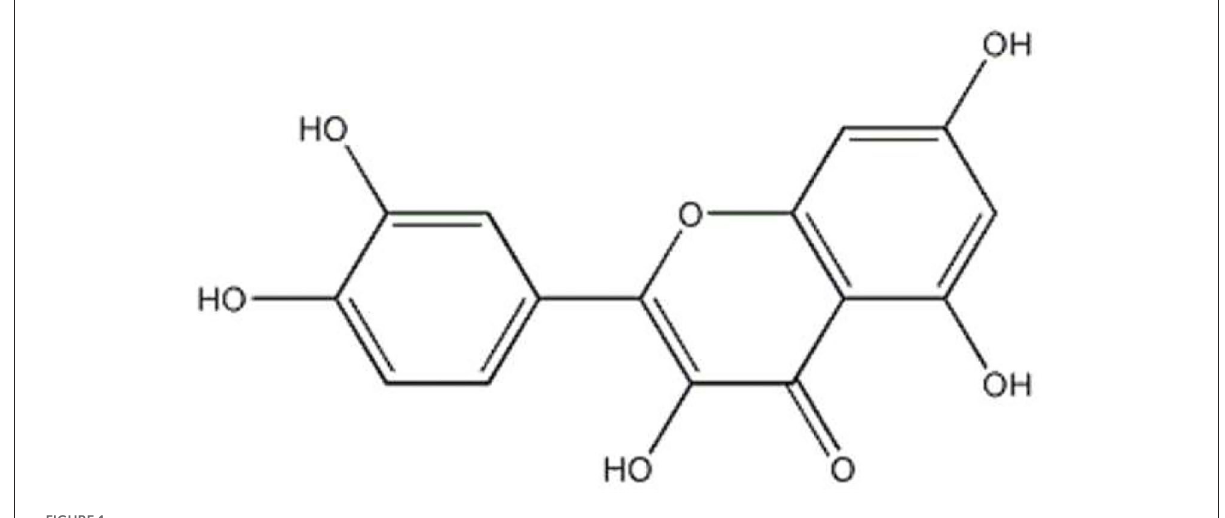
FIGURE1 Molecular structure of